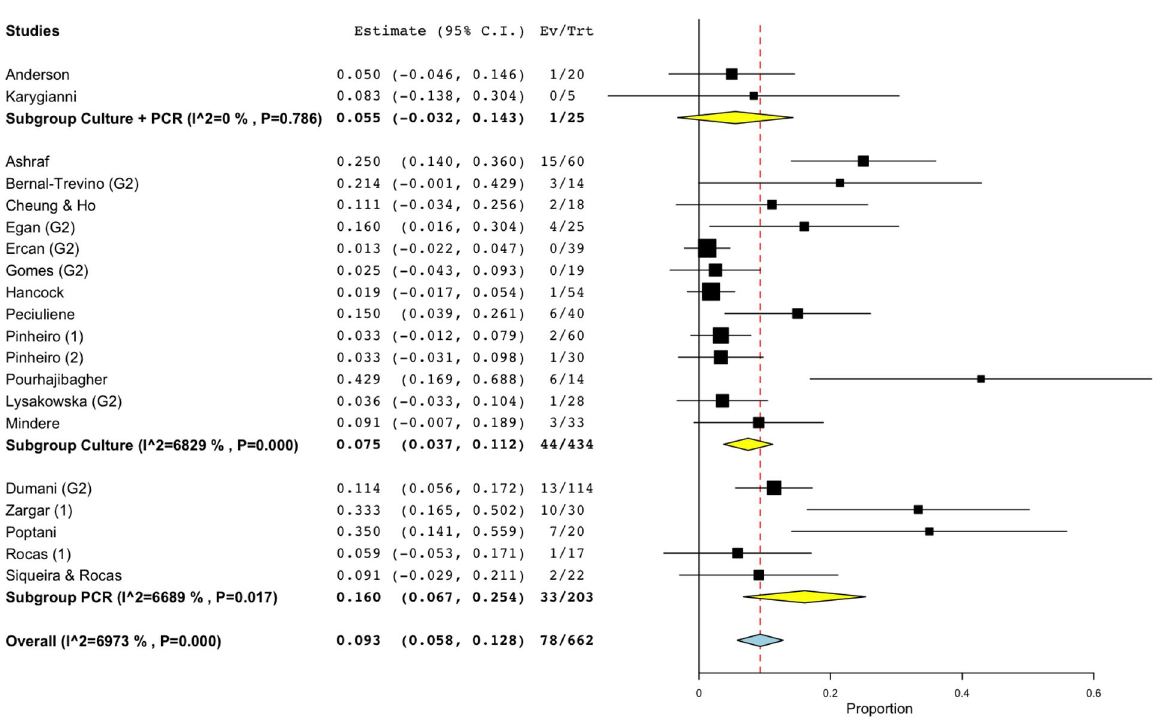
Fig 4. Forest plot representing fungal species prevalence in secondary endodontic infections, distinguishing the methods of detection.